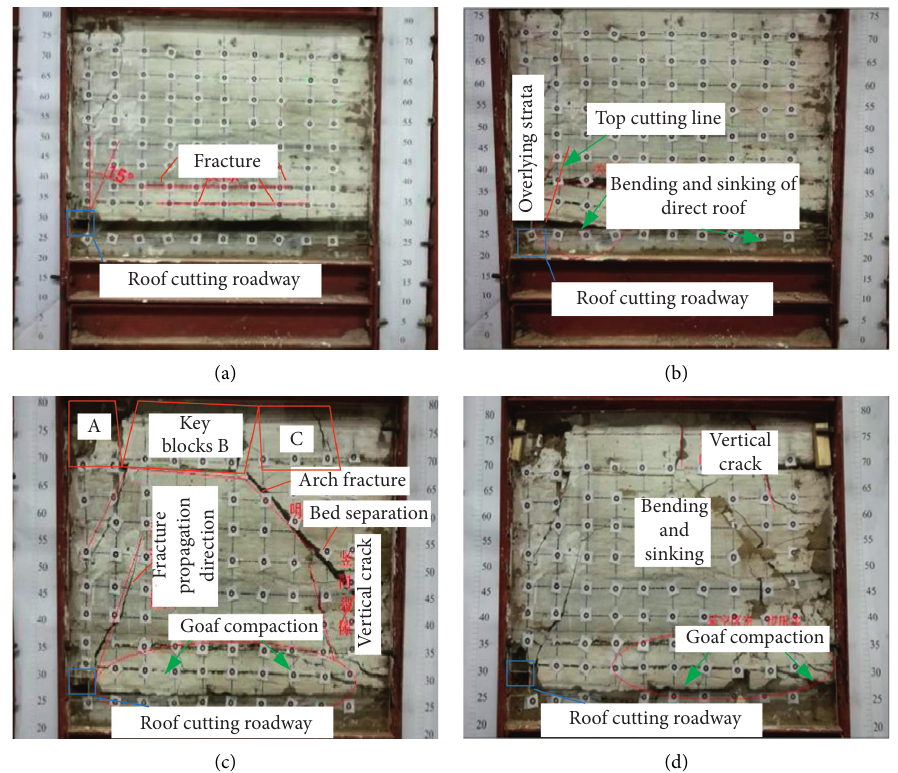
Figure 4: Dip excavation of the coal seam. Coal seam excavation: (a) 5m; (b) 20m; (c) 45m; (d) 80